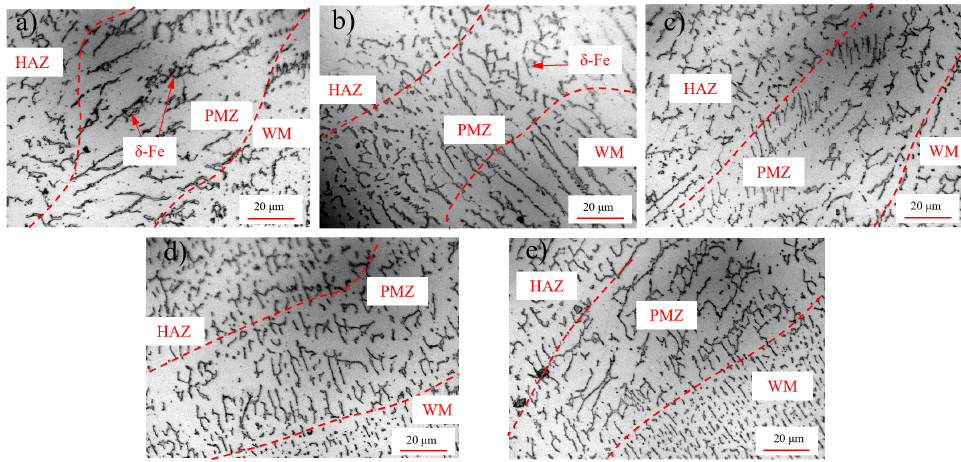
Figure 9. Morphology of the partially melted zone (PMZ) of the weld: ( a – e ) U 0 –U 4 , respectively. Through comparative experiments, it was found that the online regulation of high- energy ultrasound can play a role in refining the crystals in the melting zone. Due to the